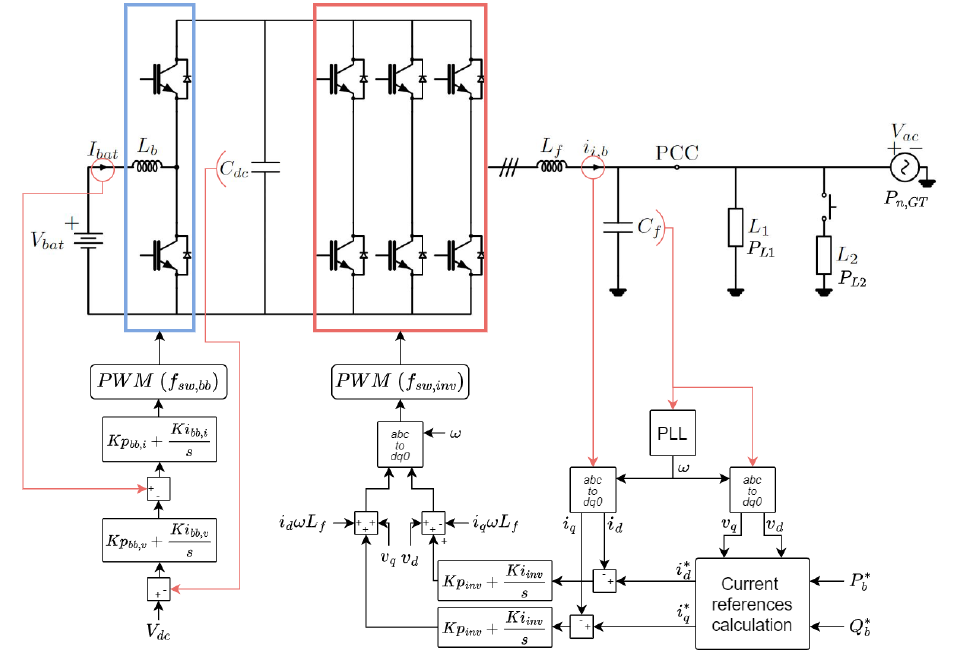
Figure 8. Block scheme of the model used for the simulation of the